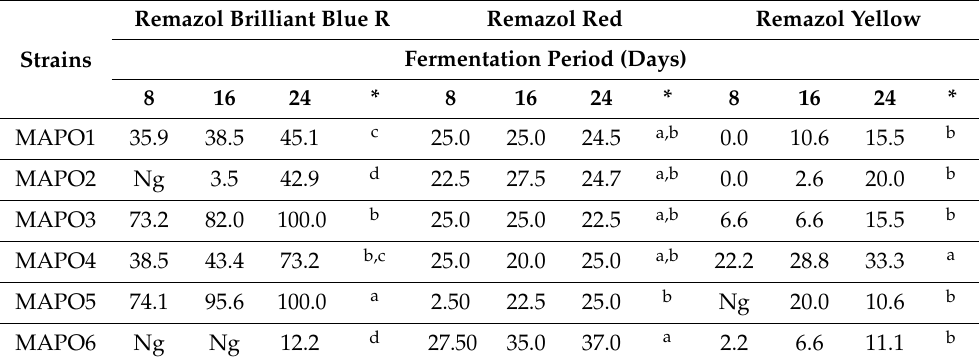
Table 3. Percentage of Remazol dyes decolorization by isolated fungi cultured in a shake flask with carbon-limited medium containing 150 mg L − 1 dye. Remazol Brilliant Blue R Remazol Red Strains